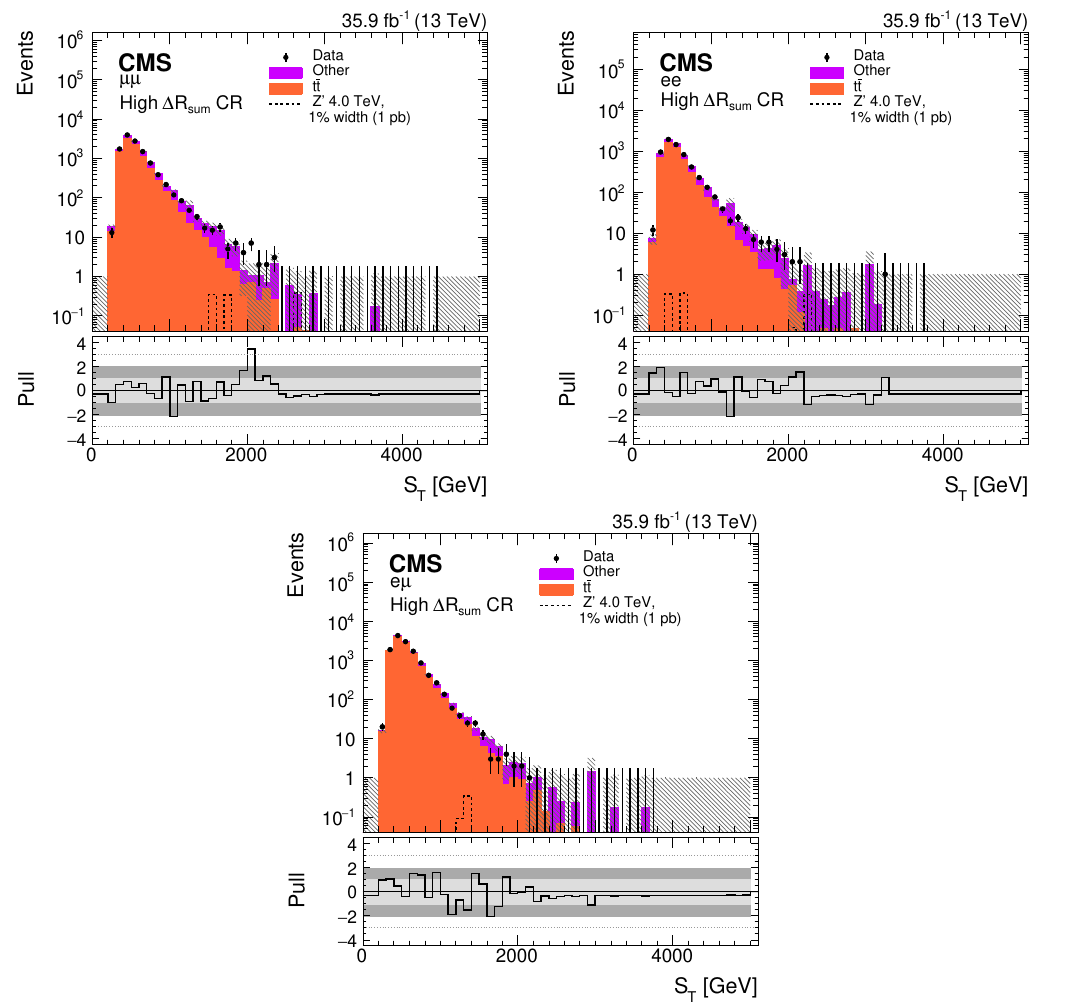
Figure 5 . Distributions of S T in the background-enriched CR for (cid:22)(cid:22) (upper left), ee (upper right), and e (cid:22) (lower) subchannels. The contribution expected from a 4 TeV Z 0 boson, with a relative width of 1%, is shown normalized to a cross section of 1 pb. The hatched band on the simulation represents the uncertainty in the background prediction. The lower panel shows the pull of each histogram bin from the SM prediction. The light (dark) gray band represents a pull of one (two) standard deviations (s.d.) from the predicted